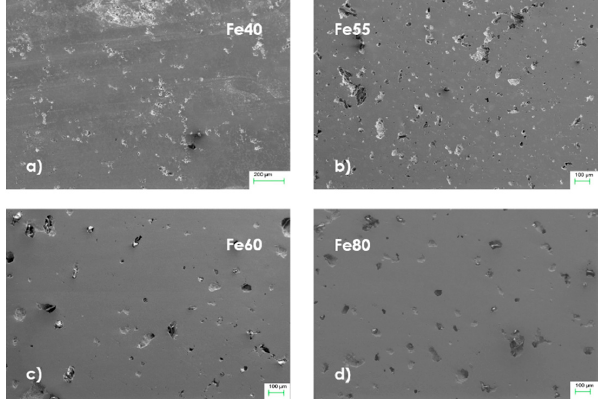
Figure 1. SEM microphotographs taken by backscattered electrons on the polished surface of the samples ( a ) Fe40, ( b ) Fe55, ( c ) Fe60, and ( d ) Fe80.